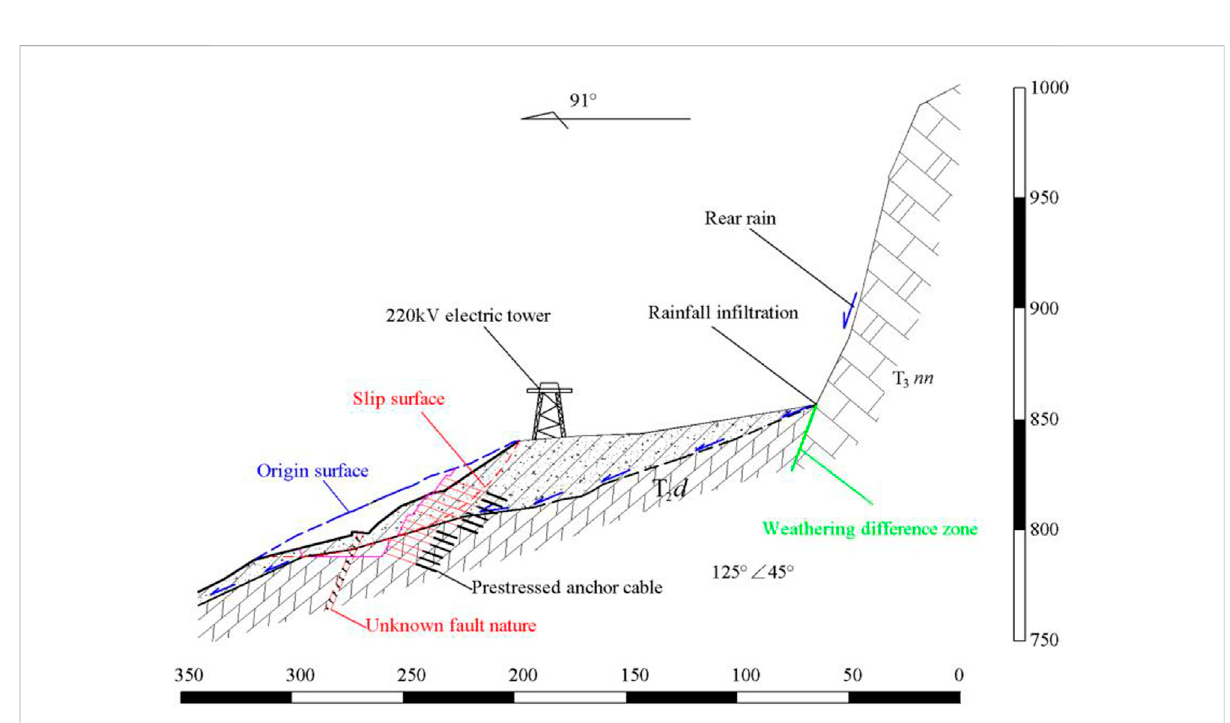
appears and rapidly penetrates the whole slope (Figure 8). Therefore, themain reasons forthe landslide are asfollows. 1) The soil has a high porosity, low shear strength, and developed seepage channels. Rainfall